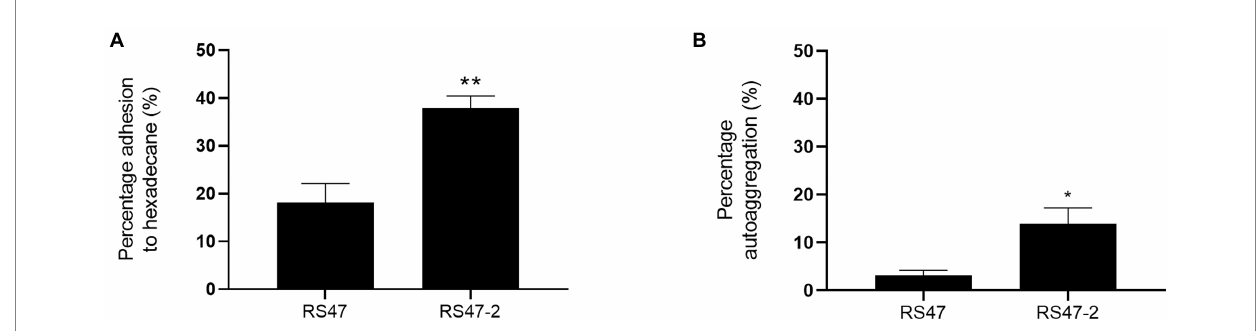
FIGURE 2 Impact of LPS alterations on hydrophobicity and autoaggregation in RS47-2. (A) The hydrophobicity of Proteus mirabilis clinical isolate RS47 WT and RS47-2 was evaluated by measuring percentage (%) adhesion to hexadecane. (B) Autoaggregation of RS47 WT and RS47-2 cells after 2 h incubation at room temperature. All data represent the mean of 3 biological replicates. Error bars show standard error of the mean (SEM). * p ≤ 0.05. ** p ≤ 0.01.